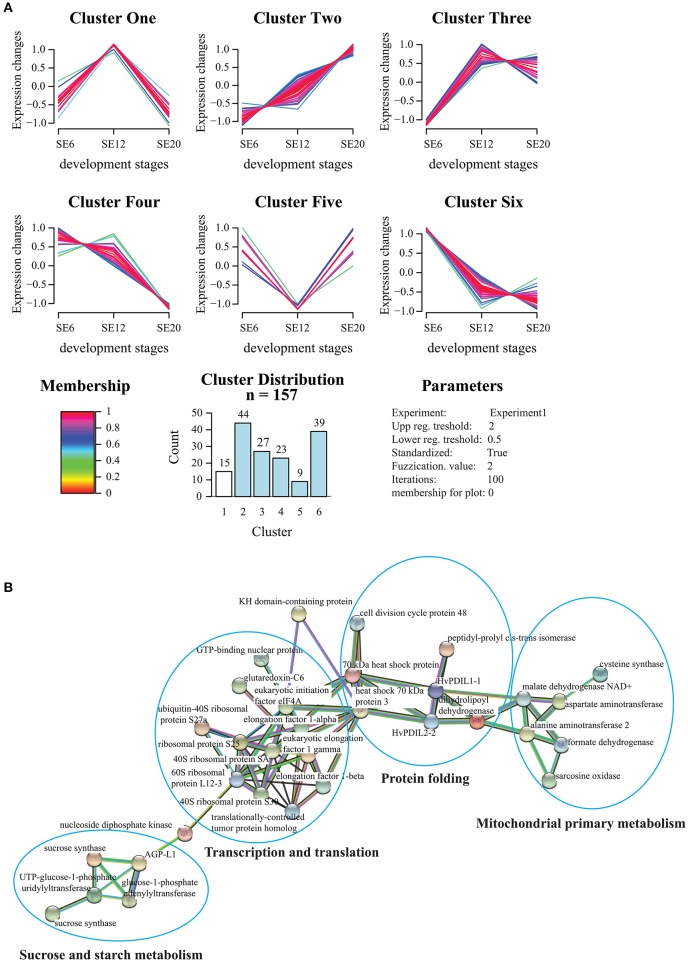
Functional analysis of the starchy endosperm proteome. (A) The 157 proteins detected and quantified by LC-MS out of the starchy endosperm LMD approach were clustered with the fuzzy algorithm from GproX (Rigbolt et al., 2011). In total 6 relevant clusters were identified (Table S2 sheet G). Membership value represents how well the protein profile fit the average cluster profile. Membership of plot = 0 indicate that no threshold was applied to plot protein abundance pattern. (B) Proteins with similar abundance patterns as HvPDIL1-1 present in cluster Three (and some in cluster Four) were analyzed by STRING database. STRING default parameters were used (Franceschini et al., 2013). Protein names are indicated.